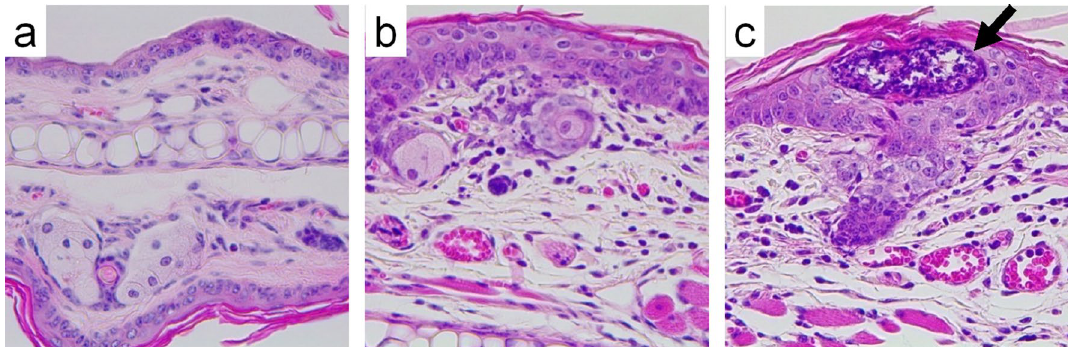
Figure 5. Representative histological changes in the auricular skin from mice after one DNFB induction and three challenges, 1 week apart. No pathological changes were observed in vehicle control mice ( a ). The epidermis, dermis, and subcutaneous tissue of the specimens were thickened, and edema, hyperemia, and infiltration of inflammatory cells were observed in the thickened tissues ( b ). The arrow shows microabscesses in the epidermis ( c ). The histological changes observed in ( b ) and ( c ) were confirmed in all DFNB-treated mice (n =